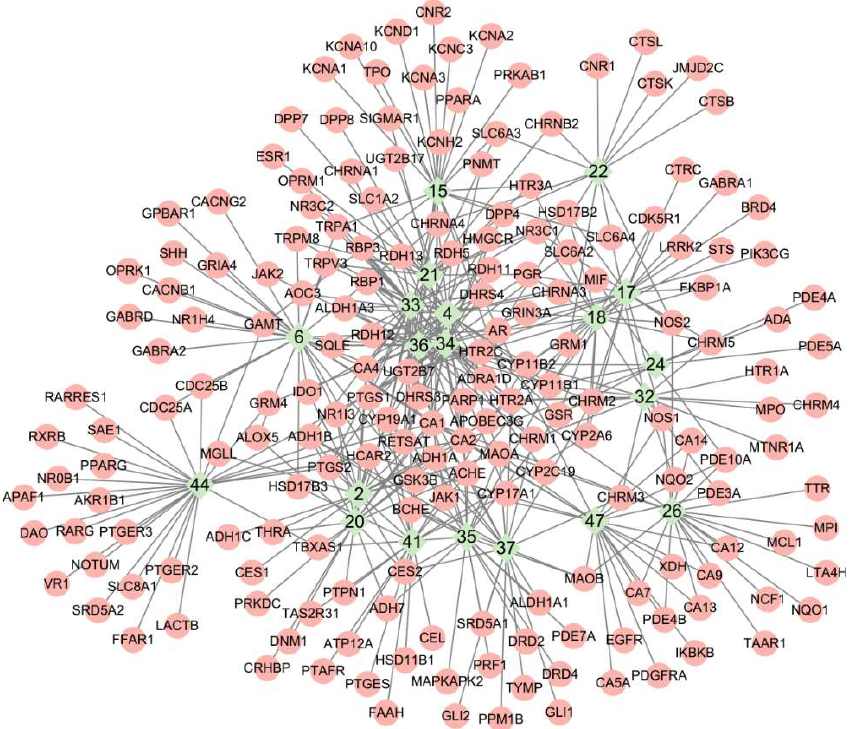
Figure 6. Compound target network of 20 essential oil compounds of woody peony flowers and 190 potential targets. Compounds are represented by green diamonds noted with numbers (see Table 2). Targets are represented by pink circles noted with standard gene names. Table 3. Ranking of the 20 essential oil compounds in the compound target network.